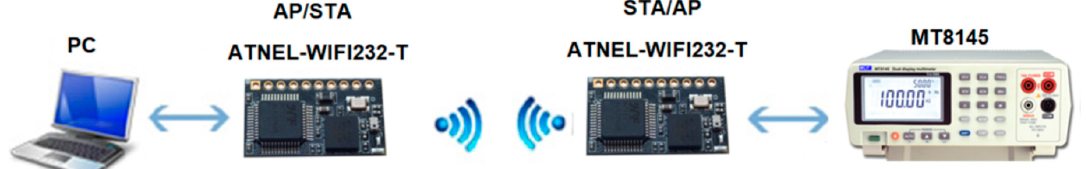
Figure 9. Configuration of the WiFi communication link.